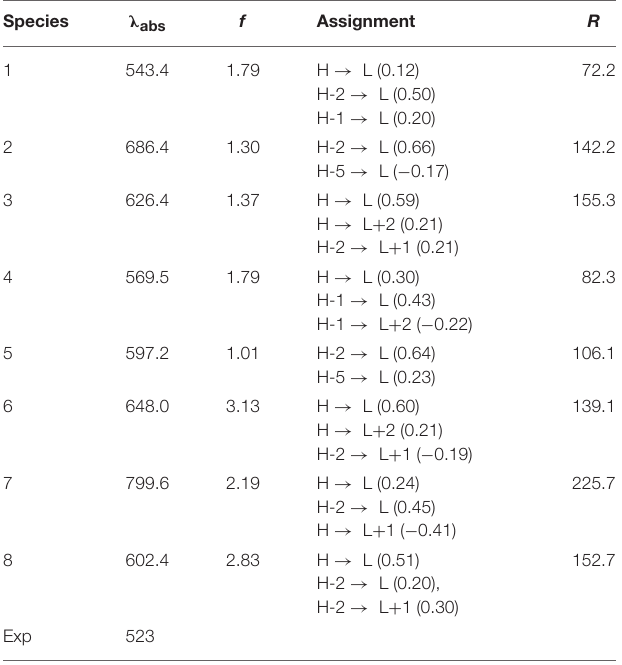
TABLE 3 | The electronic transition, absorption wavelengths λ abs (in nm), the oscillator strength f , main assignments (coefficient), and the absorption region R of 1 – 8 at the TD-PBE0/6-31G(d,p)//PBE0/6-31G(d,p) level, along with available experimental data.